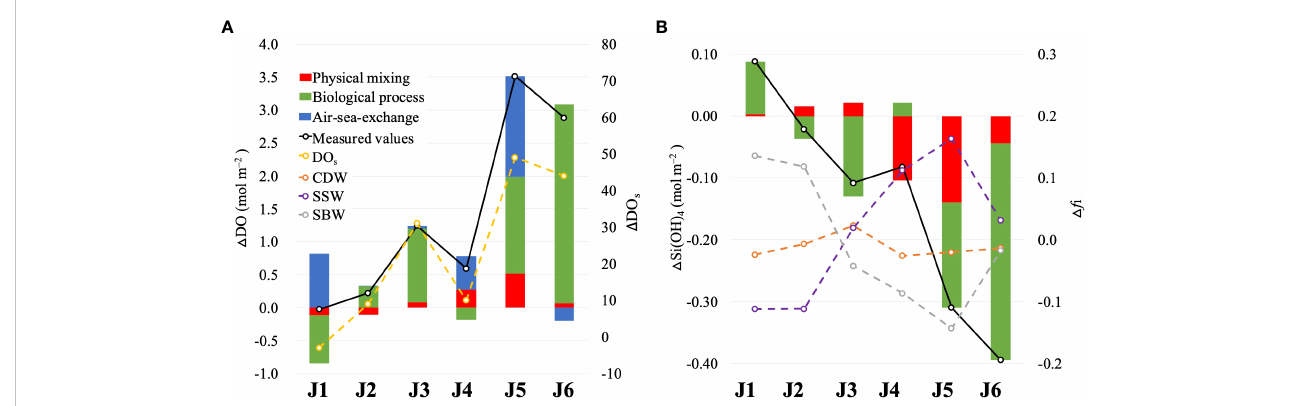
FIGURE 8 Depth-integrated concentration differences of (A) dissolved oxygen and saturation of dissolved oxygen and (B) Si(OH) 4 and f i (the fractions of three water masses) along section J (after wind minus before wind). The lines represent the differences in